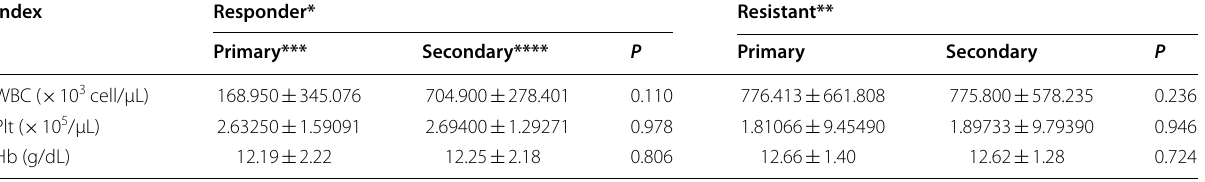
Table 5 The comparison of hematological response between responder and resistant groups